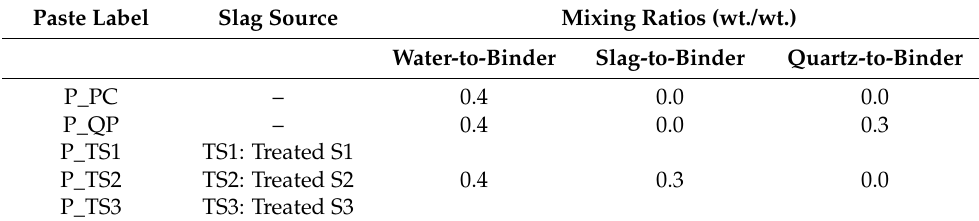
Table 5. Mixing proportions and batching values of paste